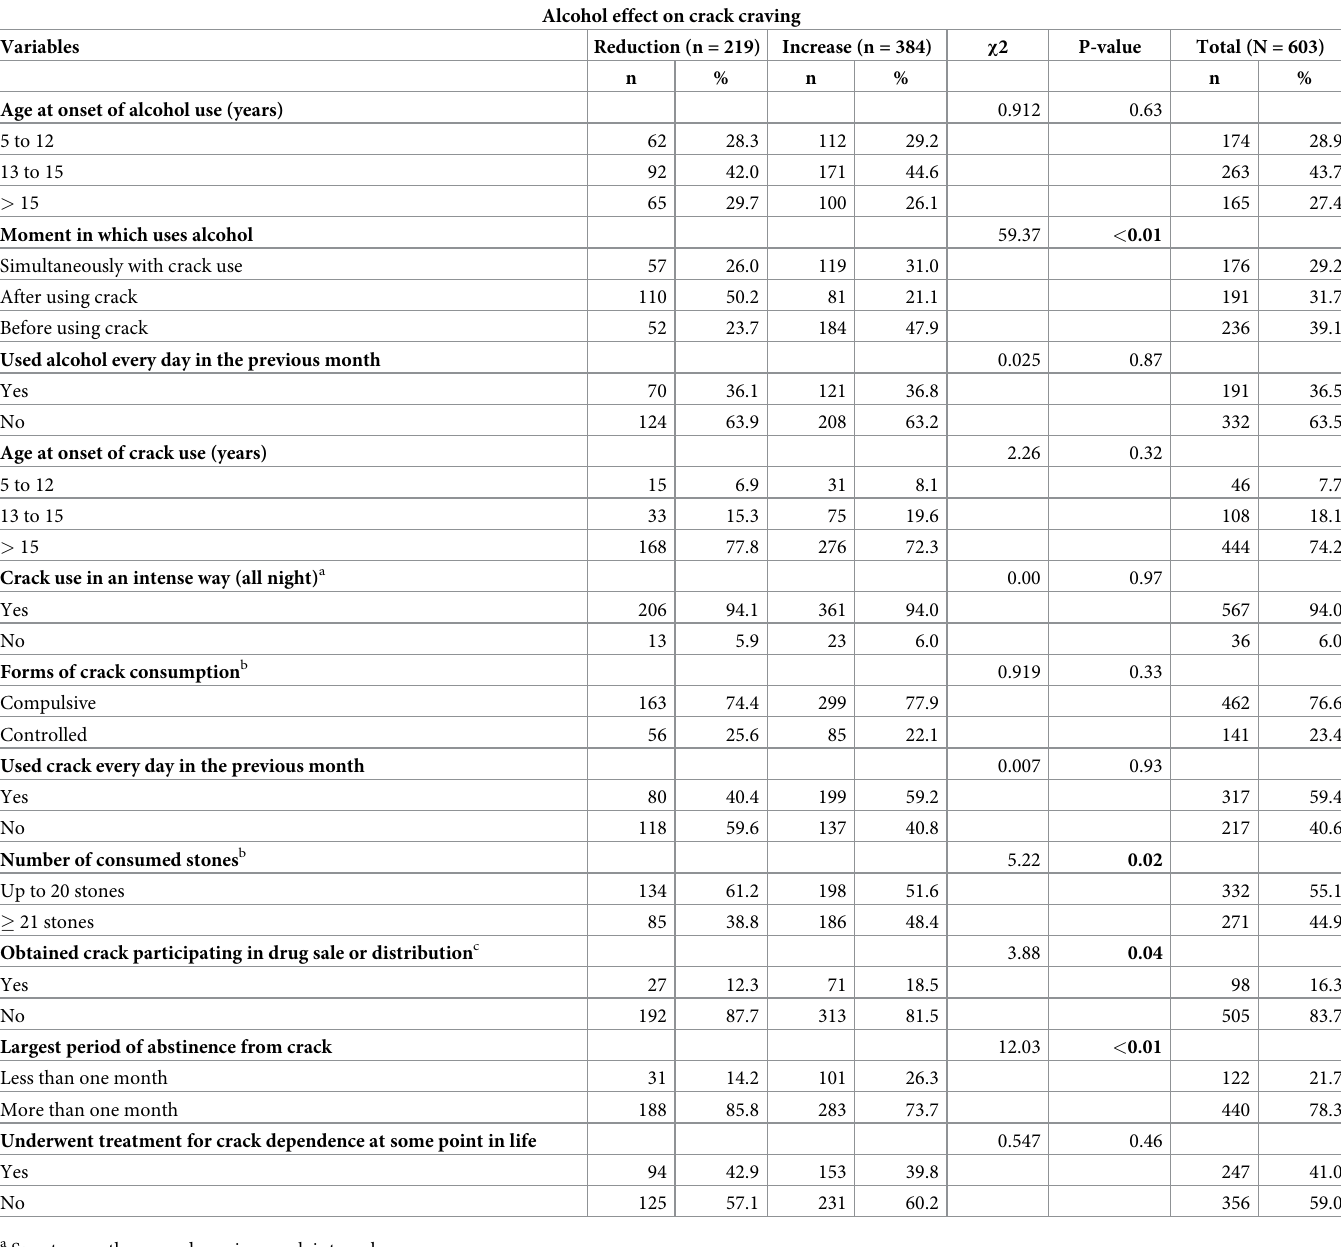
Table 2. Characteristics of crack consumption among participants assisted in the Atitude Program, Pernambuco, August 2014 to August 2015. Alcohol effect on crack